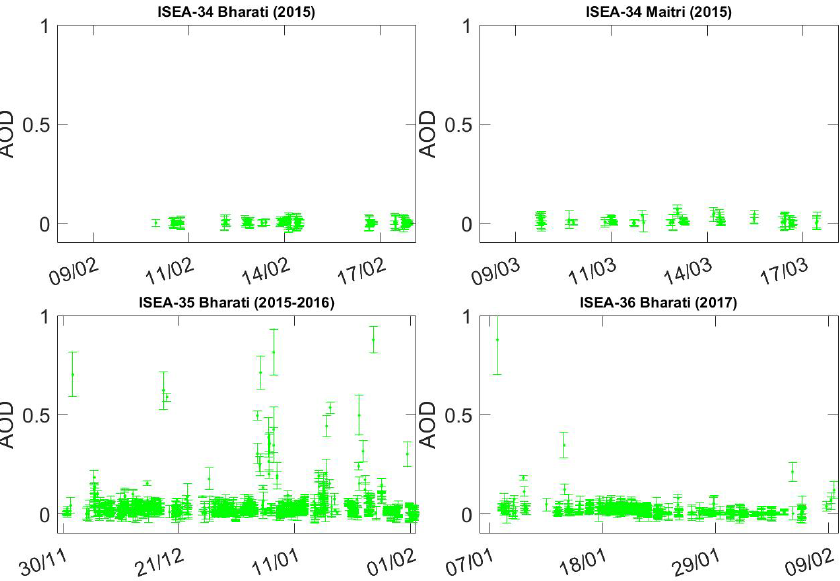
Figure 6. Aerosol optical depth time series retrieved using the O 4 DSCDs for all four campaigns are shown. The data show only the “good” data points, which are reliable and were mostly during clear sky